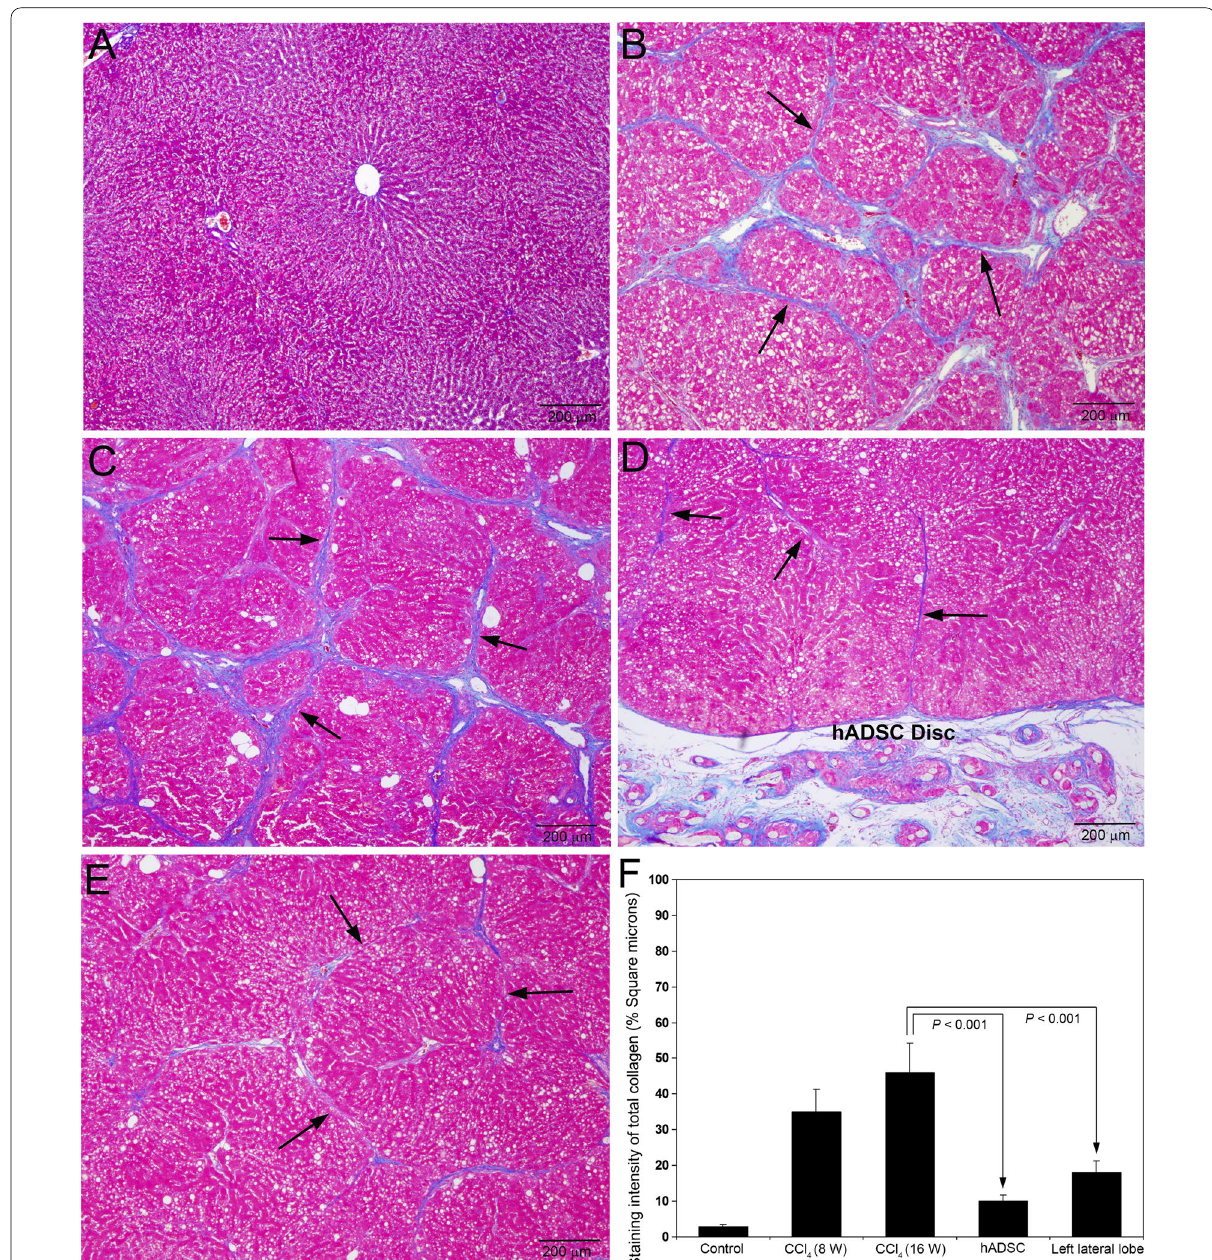
Fig. 4 Azan trichrome staining for collagen in rat liver sections following serial administrations of CCl 4 and after treatment with hADSC disc. A Staining for collagen was absent in the control livers treated with olive oil for 16 weeks. B Serial administrations of CCl 4 for 8 weeks produced well developed fibrosis and early cirrhosis with deposition of mature collagen fibers (arrows). C At 16th week of CCl 4 administration, the collagen fibers became thick and more prominent with well developed cirrhosis (arrows). D Treatment with hADSC disc for 8 weeks during CCl 4 administration resulted in more than 50% decrease of collagen fibers and incomplete fibrous septa (arrows). The hADSC disc which is surgically implanted on right lateral lobe of the liver is visible at the bottom portion. E Marked reduction of cirrhosis on left lateral lobe of the liver in which the animal is treated with hADSC disc on right lateral lobe. The collagen fibers were thin with incomplete fibrous septa and partial bridging (arrows). Original magnification, 40. F The staining intensity of total collagen was quantified using Image-Pro Discovery software. The data are mean × randomly selected microscopic fields from five rats per